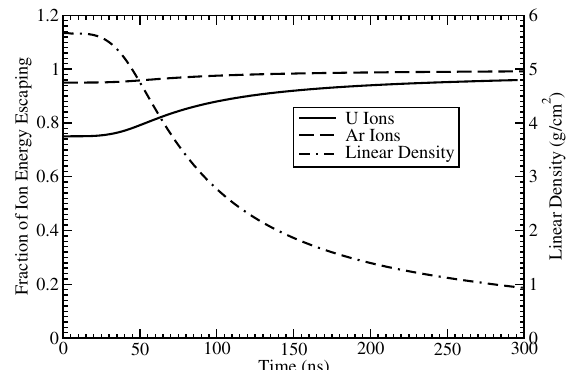
0 FIG. 26. Line density (linear density), fraction of energy of the ions of the diagnostic beam escaping the target vs time, employing the beam-target geometry shown in Fig. 4(a), using a main uranium beam having 10 12 particles of 1 : 0 GeV = u uranium, focal spot radius (full width at half maximum) (cid:3) 1 : 0 mm , pulse duration, (cid:11) (cid:3) 50 ns . Two different diagnostic beams are considered, a uranium 1 GeV = u uranium beam with an intensity of 10 6 particles and a (cid:11) (cid:3) 1 (cid:4) s and an argon beam with a particle energy of 1 : 095 GeV = u , an intensity of 10 6 and a (cid:11) (cid:3) 1 (cid:4) s . The target is a cylinder made of solid lead with a length L (cid:3) 5 : 0 mm and radius (cid:3) 2 : 5 mm